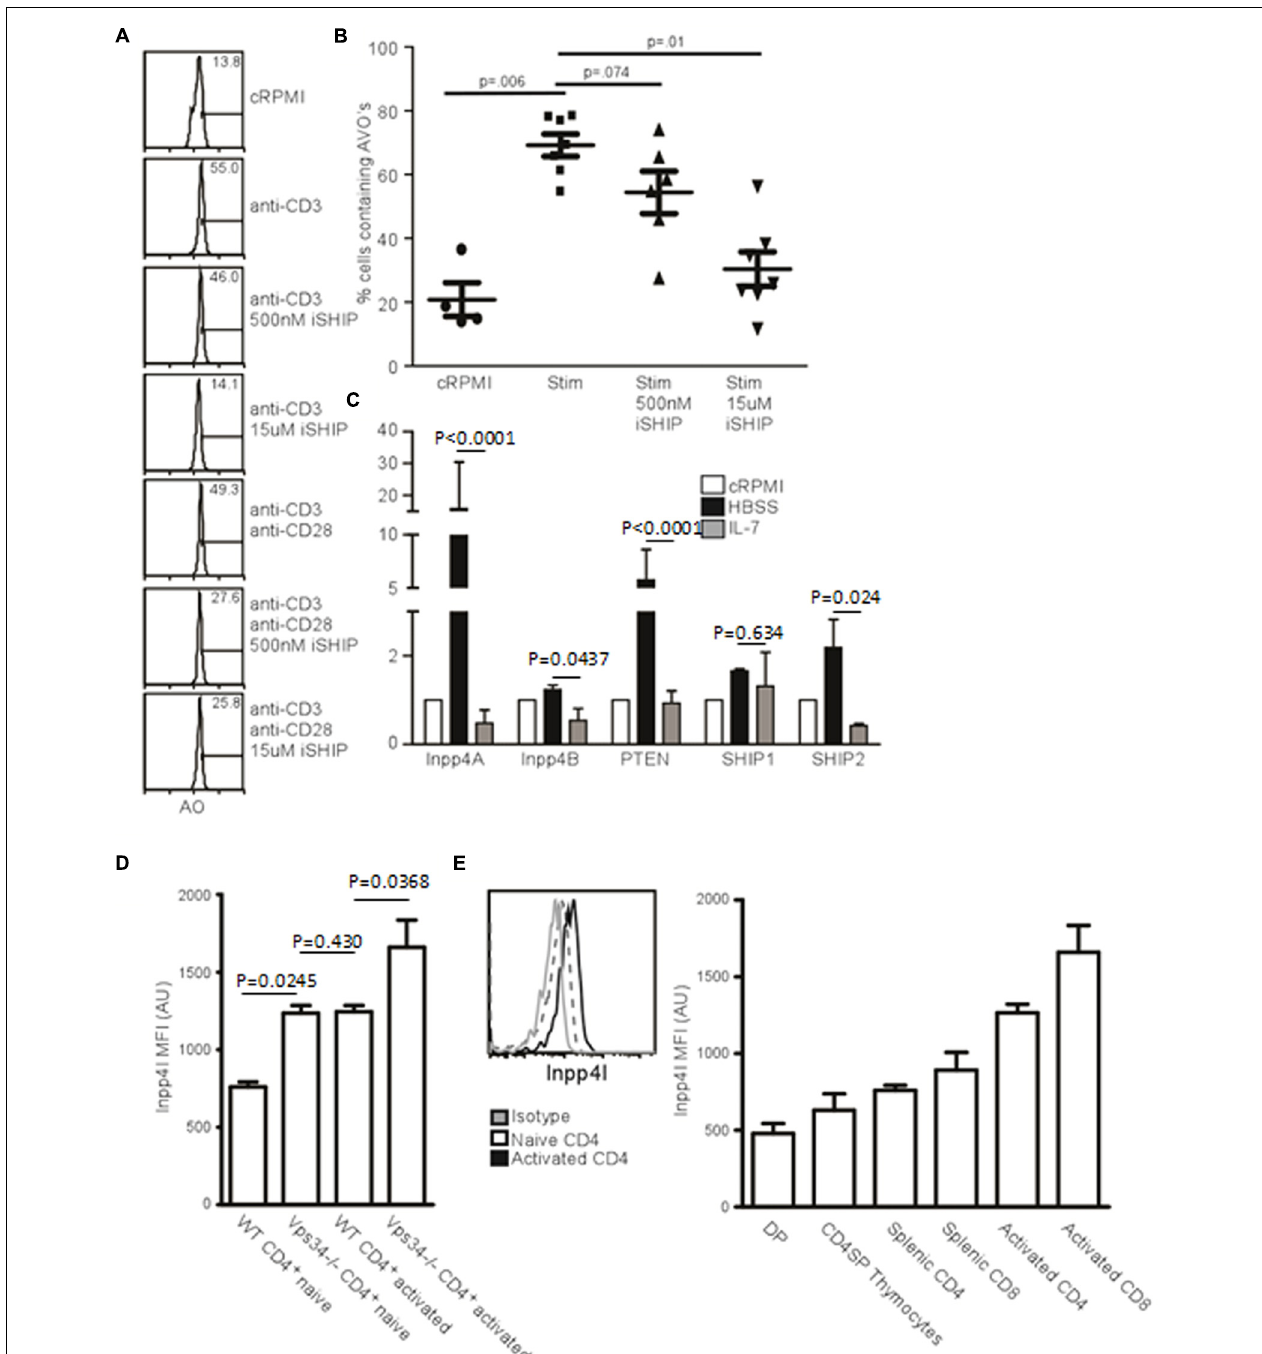
FIGURE 5 | Inositol phosphatases respond to autophagic stimuli. (A) AVO formation in CD4 T lymphocytes pre-treated with 500 nM or 15 uM Anchor (AS1949490) for 1 h and stimulated with either 1 µ g/mL soluble anti-CD3 alone or with anti-CD28 for 24 h. 500 nM Anchor inhibits SHIP2 activity and 15 µ M inhibits both SHIP1 and SHIP2. (B) Quantification of AVO’s from (A) . p -values are from paired, two tailed, Student’s t -tests from 6 replicates in 3 independent experiments. (C) Relative levels of inositol phosphatase mRNA in CD4 T cells 48 h after starvation in HBSS or with 10 ng/mL IL-7. QPCR results were normalized to that of GAPDH. Data are representative of 3 independent experiments with 3 replicates per experiment. (D) Histogram of Inpp4A protein level in naïve or 24 h stimulated CD4 T cells, quantified in the right panel as 4 replicates from 3 independent experiments. Gray histogram represents the isotype control, the dotted histogram is the naïve level, and black histogram is the level in TCR activated cells. (E) Intracellular stains for Inpp4A protein levels in WT or Vps34 f / f Lck-cre CD4 T cells (Vps34-/-). Data are from 3 replicates in 2 independent experiments.